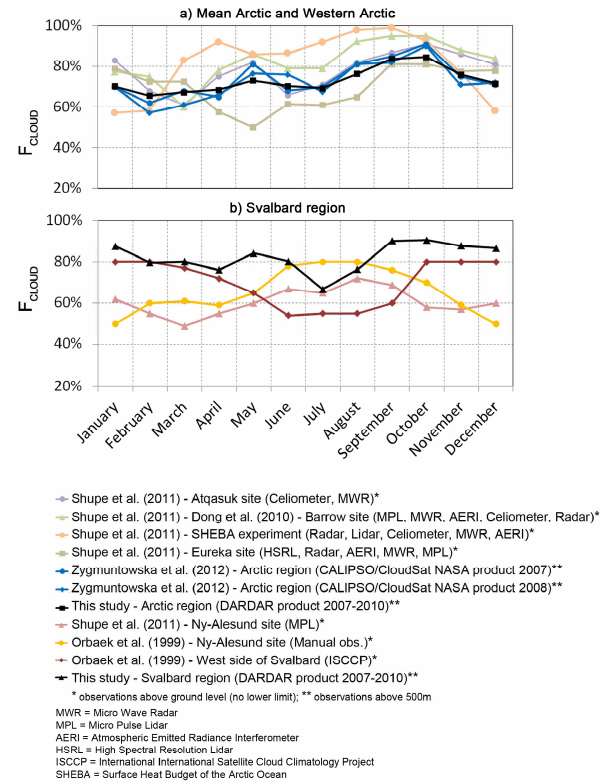
Figure 5. Monthly total cloud occurrence in the Arctic from ground and spaceborne remote sensing observations: (a) over the entire Arctic region and Western Arctic ground-based sites; (b) over the Svalbard region.